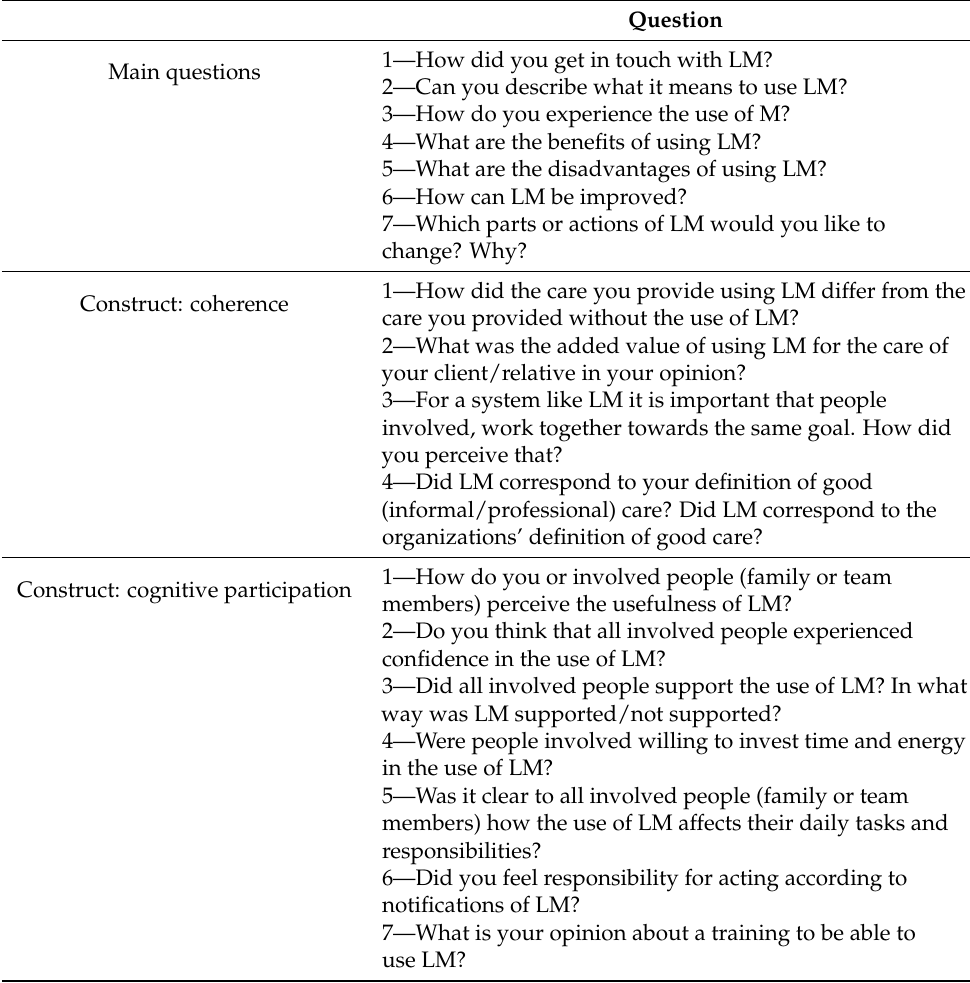
Table A1. Interview guide according to